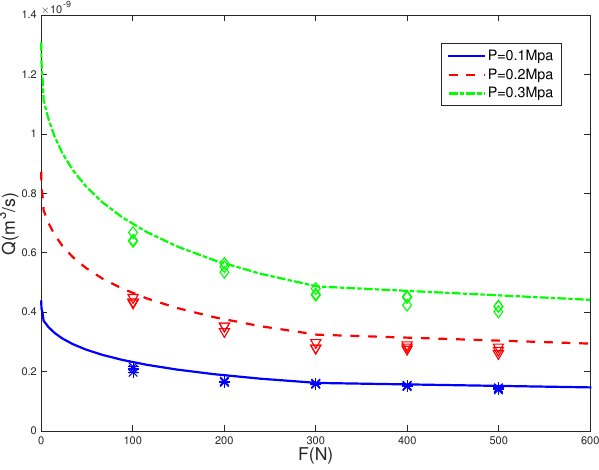
Figure 7. The leak rate versus the contact load through the fluid pressure for three values.